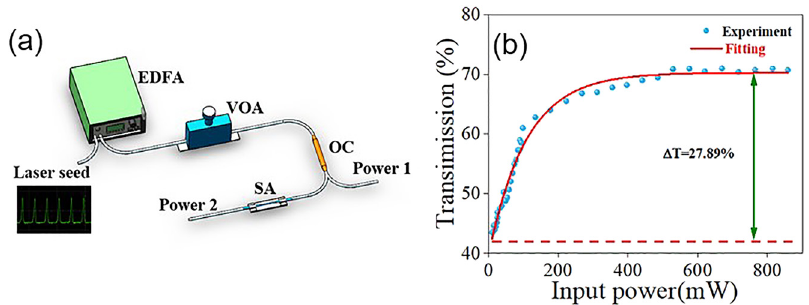
Figure 5: (a) Dual channel detector, (b) transmission curves of GDY saturable